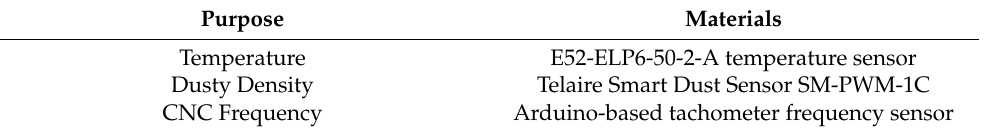
Table 1. Materials